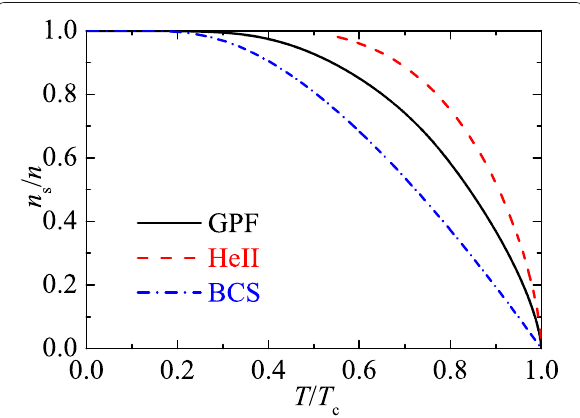
Fig. 3 The superfluid fraction of a unitary Fermi gas, predicted by the Gaussian pair fluctuation (GPF) theory (black solid line) and mean-field BCS theory (blue dot-dashed line). For comparison, the superfluid fraction of superfluid helium is also shown by a red dashed line. Note that, the GPF theory predicts a spurious bend-back structure near the superfluid transition [19]. This unphysical behavior has been rectified [14], by extrapolating the reliable results below T c with the correct critical scaling behavior n s / n ∝ ( 1 − T / T c ) − ν , with ν (cid:3) 2 / 3. Here, the critical temperature of a unitary Fermi gas is T c (cid:3) 0.17 T F , as determined experimentally. The Fermi temperature /( 2 mk ) and the Fermi wavevector T F = ε F / k B = (cid:2) 2 k 2 B F